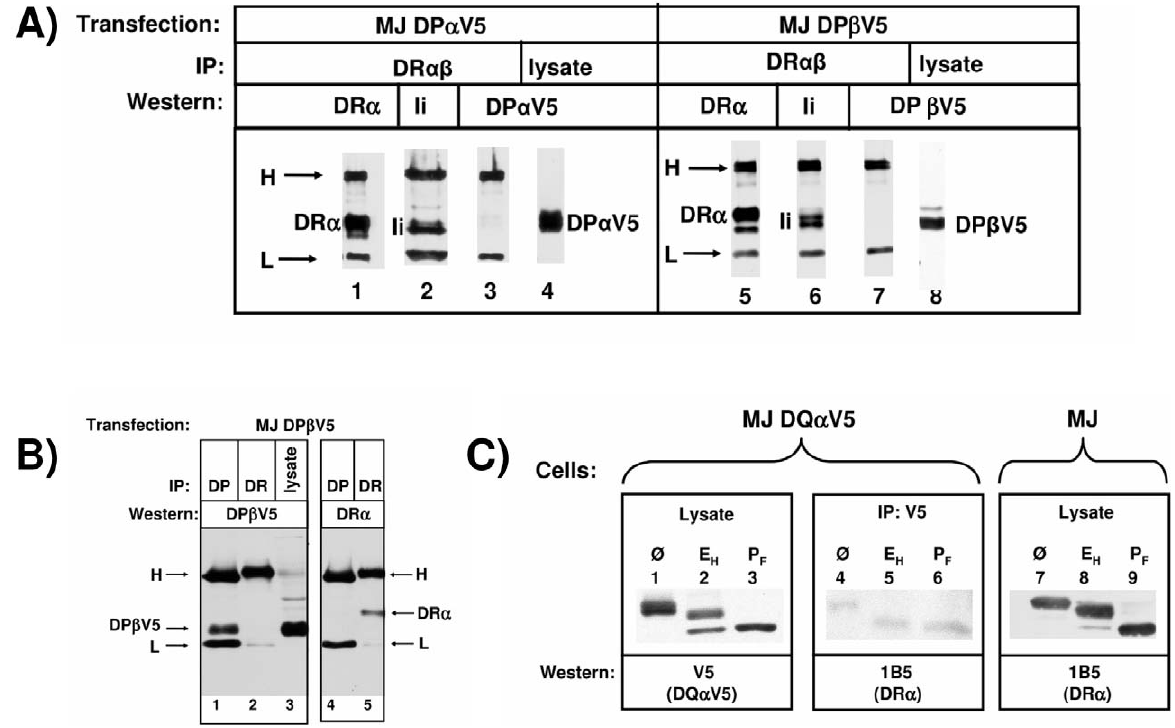
Figure 5. Inspection for co-isolation of DP and DQ isotypes with DR. A) MelJuSo cells were transiently transfected with cDNAs encoding V5- tagged DP a or DP b encoding cDNAs. Cells lysed in 1% NP40 were immunoprecipitated for DR ab (monoclonal antibody ISCR3) (lanes 1,2,3,5,6 and 7). Lanes 4 and 8 contain cell lysates. The SDS-separated polypeptides were immunoblotted for DR a (lanes 1 and 5), for Ii (lanes 2 and 6), and for DP a V5 (lanes 3 and 4), or for DP b V5 chains (lanes 7 and 8). The position of DR a , Ii and Ab-epitope tagged DP a V5 or DP b V5 bands is indicated. H and L chain bands derived from the Ab used for immunoprecipitation are labeled on the left. B) Immunoprecipitates of the V5-tagged DP b (lanes 1 and 4) and of DR ab (lanes 2 and 5) chains were separated by SDS-PAGE and either blotted for DP b V5 (lanes 1 to 3) or for DR a (lanes 4 and 5). To monitor expression of DP b V5, lane 3 contains cell lysate. The position of DP b V5, of DR a and of H and L Ig chains are indicated. C) MelJuSo cells were transfected with V5- tagged DQ a cDNA. Cell lysate was immunoprecipitated for the V5-tagged DQ a chains. Immunoprecipitates (lanes 4 to 6) and cell lysates (lanes 1 to 3) were digested with EndoH (E H ), or with PNGase F (P F ) or left untreated (Ø), separated by SDS-PAGE and western blotted as indicated. In lanes 7 to 9 MelJuSo cell lysates untreated and glycosidase treated were western blotted for DR a